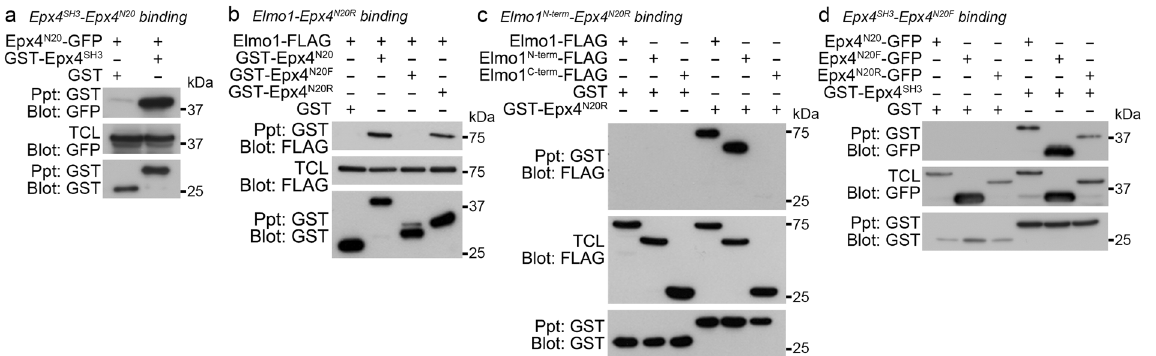
Figure 3. The SH3 domain associates with the N20 region of Ephexin4. ( a – d ) 293 T cells transfected with the indicated plasmids were lysed, and then the lysates were incubated and precipitated with glutathione–sepharose beads. Co-precipitated proteins were detected with anti-GFP ( a , d ) or anti-FLAG antibody ( b , c ). Immunoblots are cropped for conciseness and their full-length blots are shown in Supplementary S5. Epx4, Ephexin4; TCL, total cell